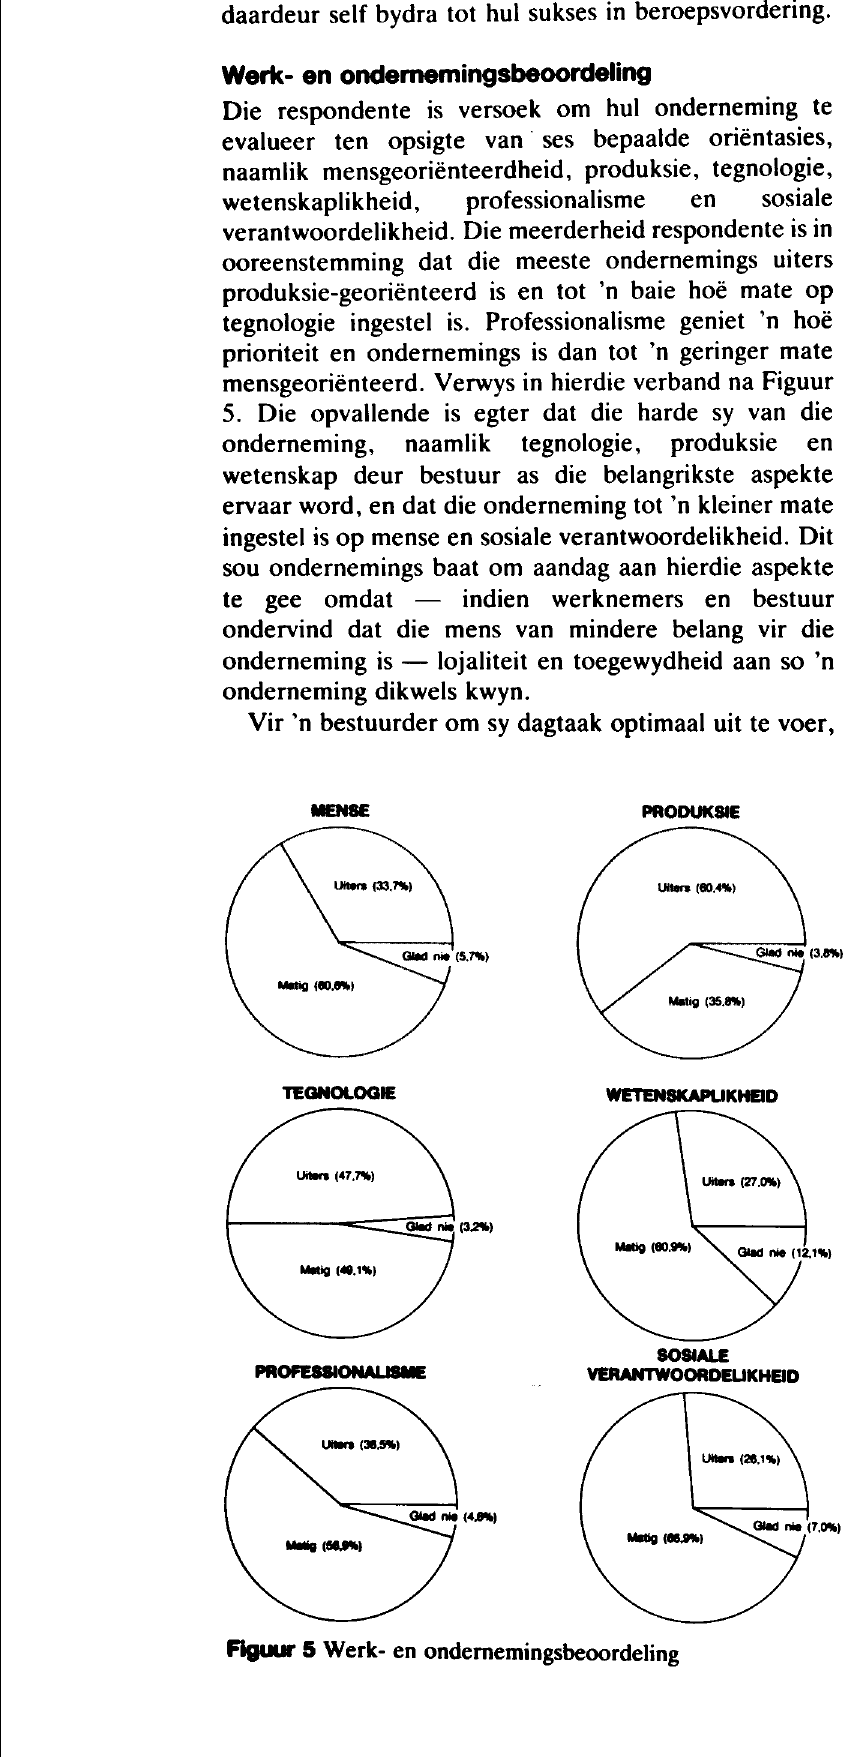
Figuur 5 Werk- en ondernemingsbeoordeling